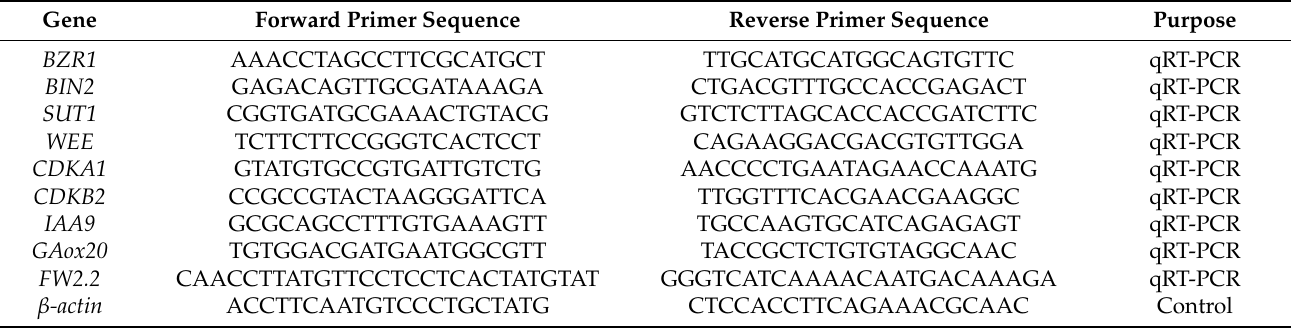
Table 1. Forward and reverse primers used in this